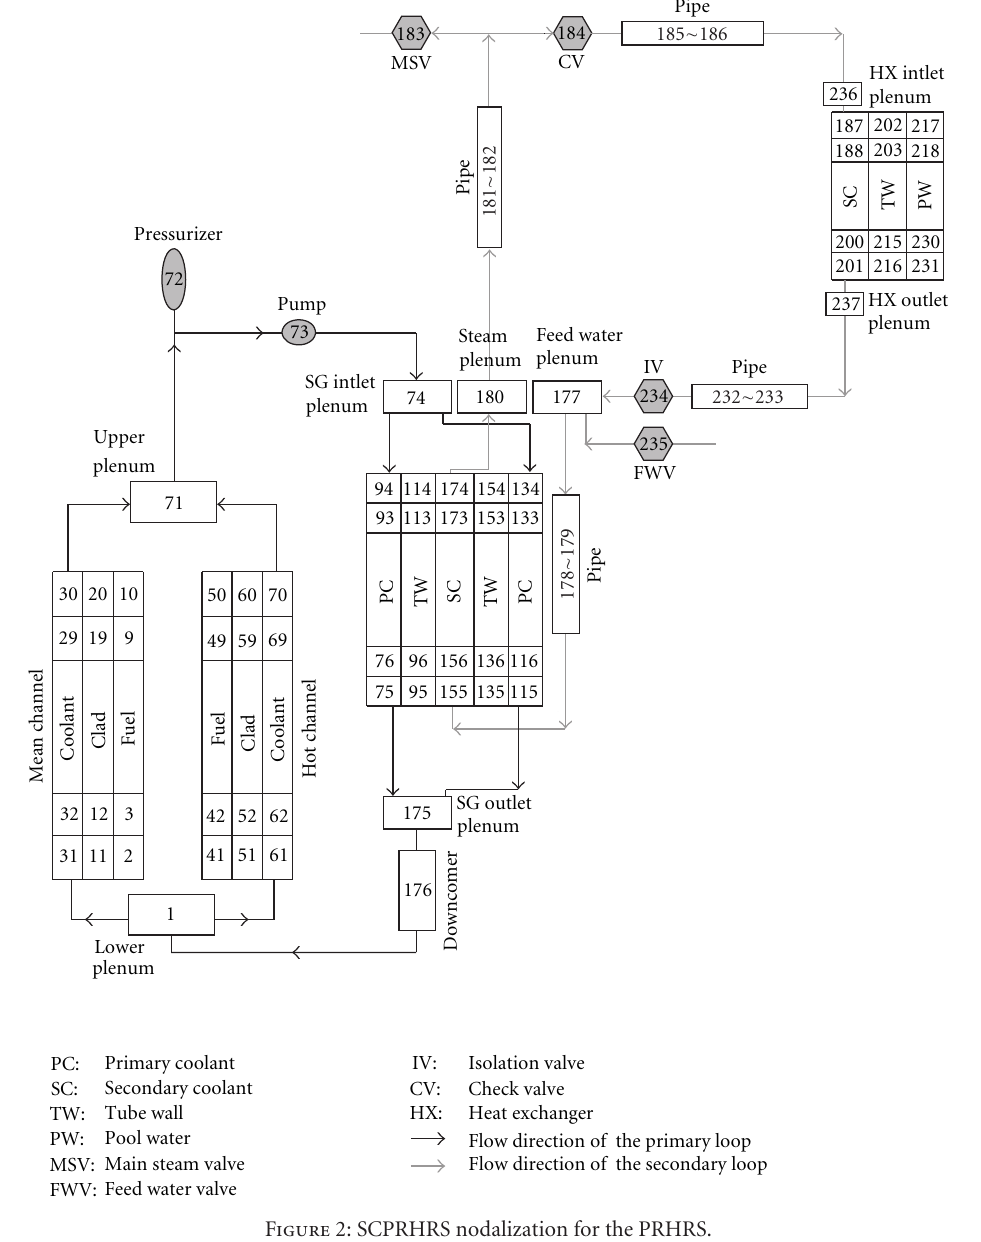
Figure 2: SCPRHRS nodalization for the PRHRS.